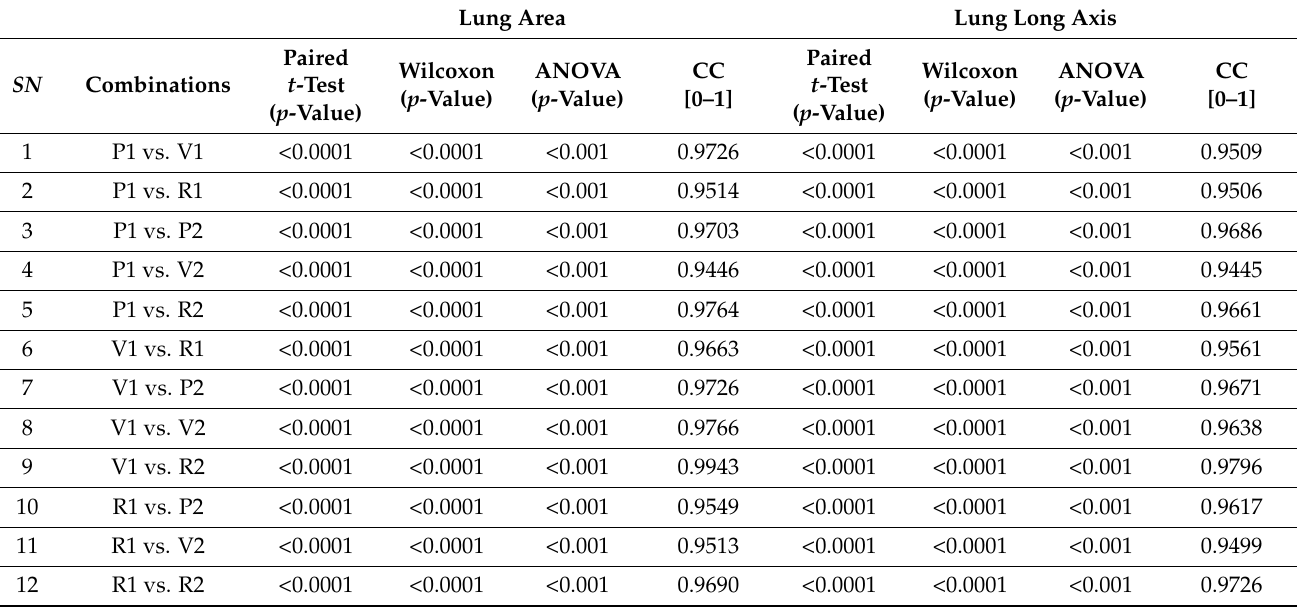
Table 3. Paired t -test, Wilcoxon, ANOVA, and CC for LA and LLA for the 12 combinations. Lung Area